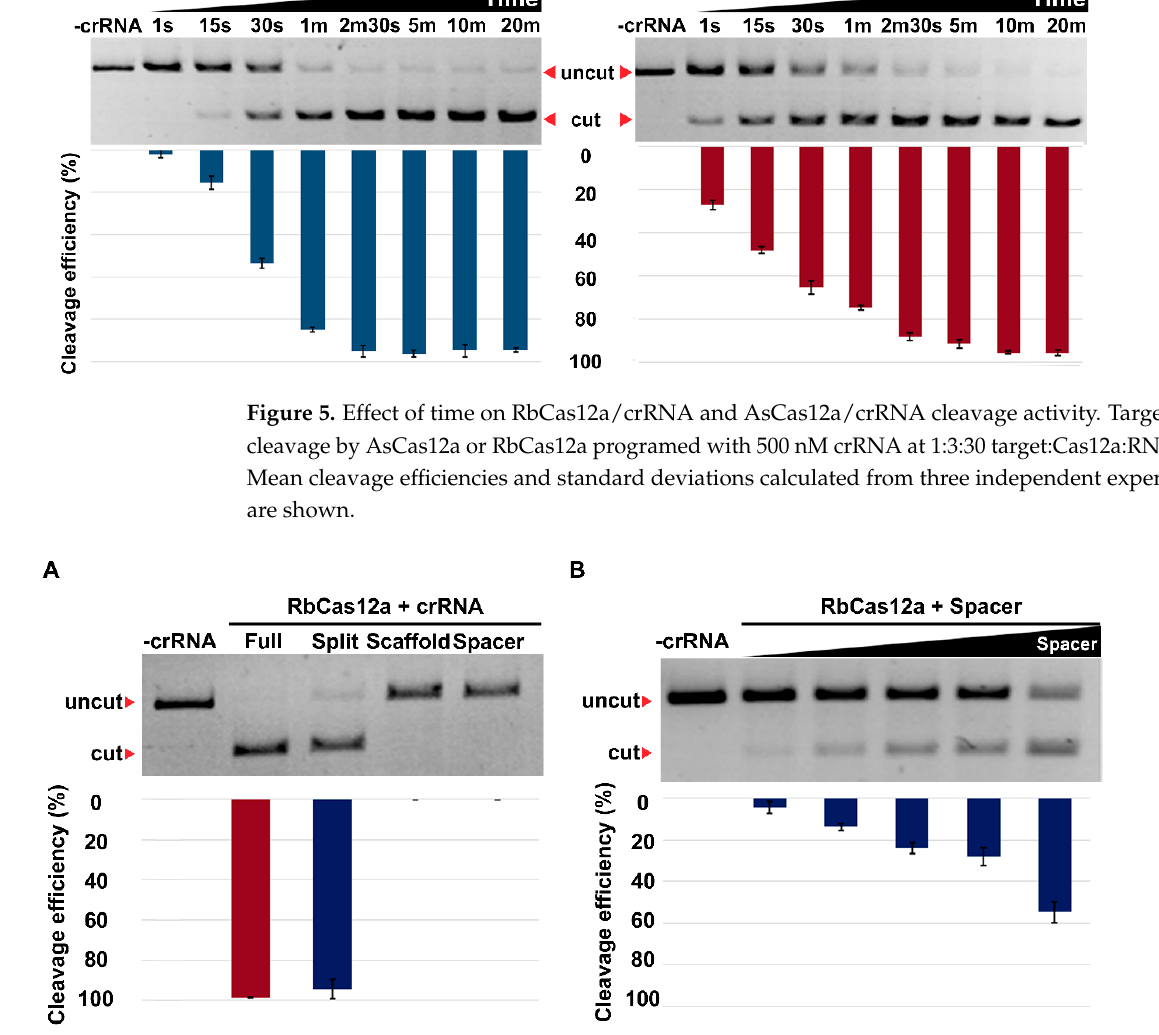
Figure 6. Effect of split crRNA and spacer-only RNA on RbCas12a cleavage activity. ( A ) Target DNA cleavage by RbCas12a programed with 0.3 μ M full-sized split or separate scaffold and spacer crRNA moieties at a 1:3:30 target:RbCas12a:RNA ratio. “ Split” reactions contained both the scaffold and spacer RNAs. Mean cleavage efficiencies and standard deviations calculated from three independent experiments are shown. ( B ) Cleavage by RbCas12a programed with increasing concentrations (0.5, 1, 2, 2.5, and 5 μ M of spacer RNA, corresponding to 1:5:50, 1:5:100, 1:5:200, 1:5:250, and 1:5:500 DNA:RbCas12a:crRNA ratios). Mean cleavage efficiencies and standard deviations calculated from three independent experiments are shown.